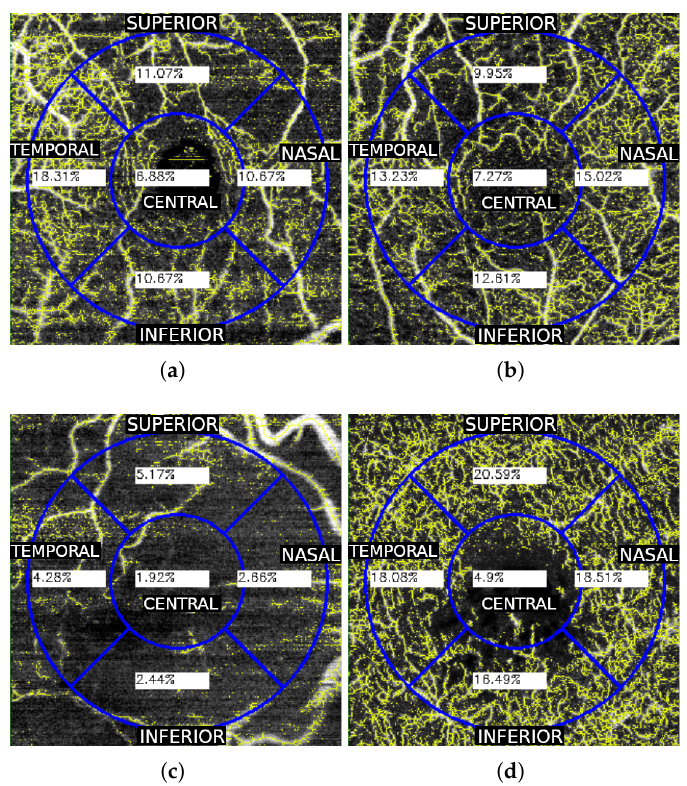
Figure 6. Representative examples of the VD extraction process by the indicated circular quadrant sections in both SCP ( a – c ) and DCP ( d ). In these examples we can see different representative degrees of VD